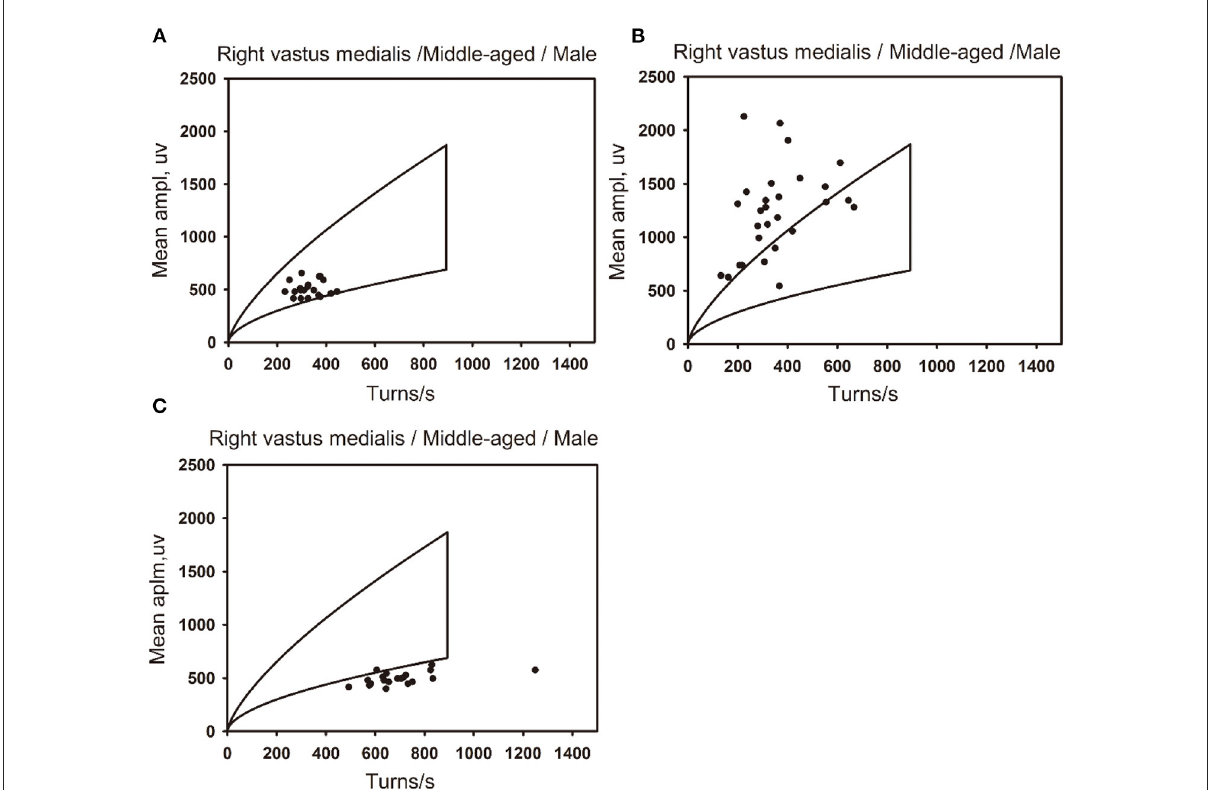
FIGURE7 The distribution of data points for normal, neuropathic lesion, and myopathic lesion muscles in the linear regression clouds. The linear regression clouds of the right vastus medialis muscle in three middle-aged men (44–59 years old). (A) The right vastus medialis muscle of a middle-aged man is defined as normal, with the muscle stats distributed within the linear regression cloud. (B) The right vastus medialis muscle of a middle-aged man is defined as neuropathic lesion, with the data points of muscle beyond the upper boundary of the linear regression cloud, which exceed 25% of all data points. (C) The right vastus medialis muscle of a middle-aged man is defined as myopathic lesion, with the data points of muscle beyond the lower and right boundaries of the linear regression cloud, which exceed 18% of all data